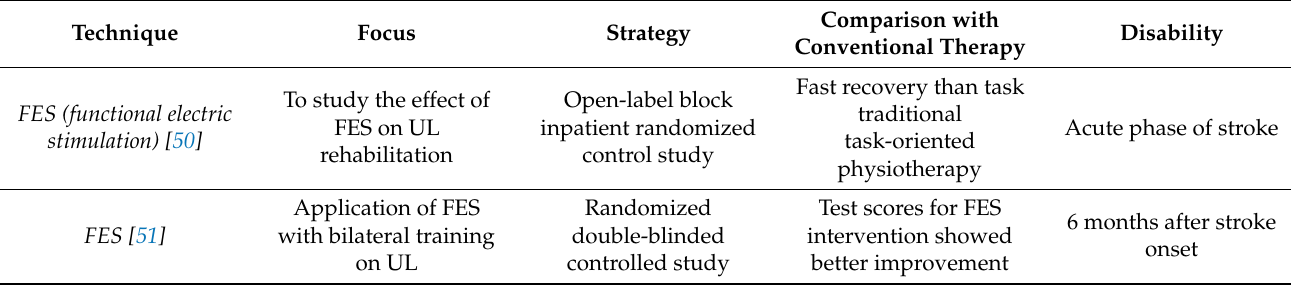
Table 5. Included Stroke Rehabilitation